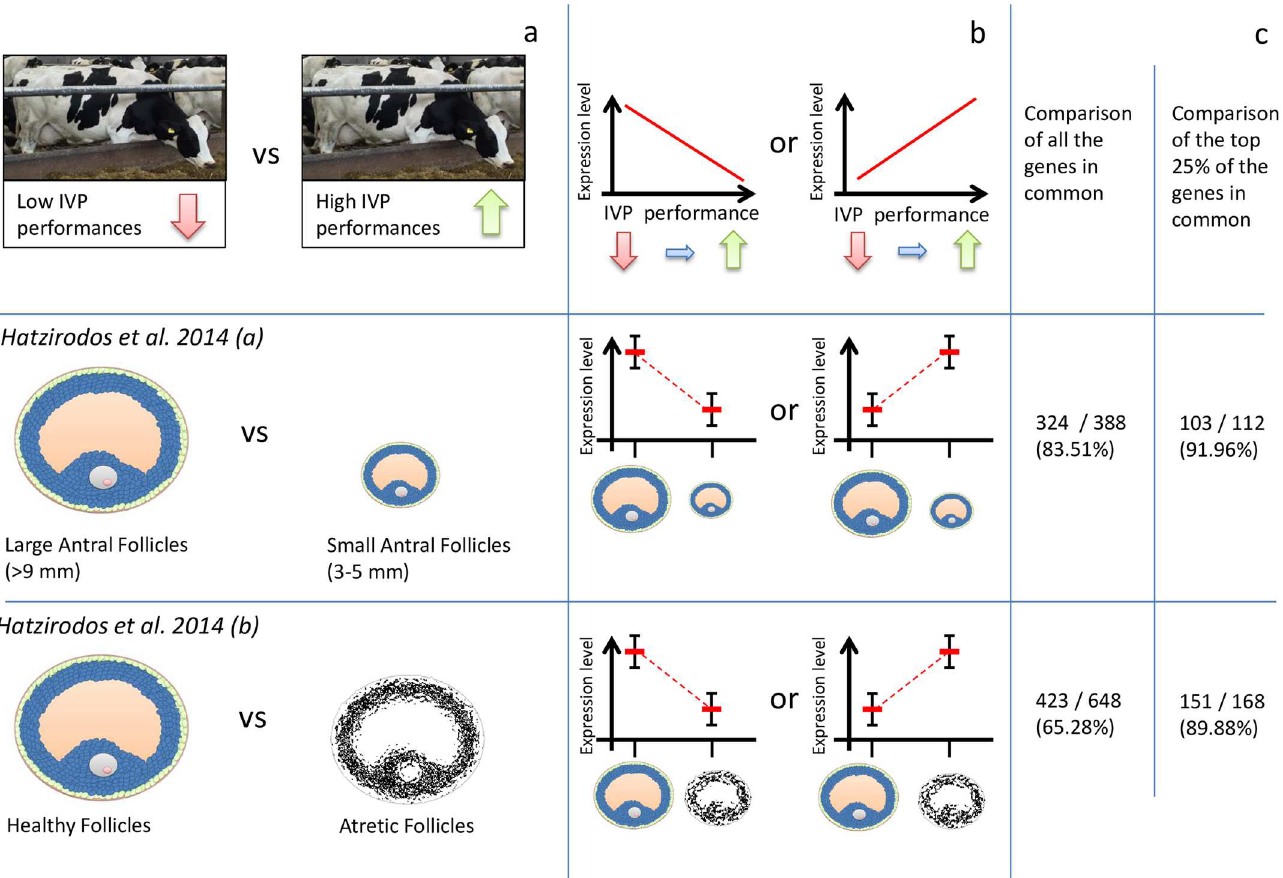
Fig 2. Comparison of expressionpattern with previous studies by (Hatzirodos et al .(a, b)) [30, 31]. ( a ) Description of our analysiswith respect to the differentialexpressionanalysesin (Hatzirodos et al .(a, b)) [30, 31]. The comparisonfrom (Hatzirodos et al .(a)) [30] is invertedin this picture in order to show the similarity of the patterns that we observed. ( b ) Explanationof the comparisons. A gene is considered to have the same trend when its expressiondecreasesor increasesin both the studies for each comparison. ( c ) Number of genesobservedwith similar trend duringthe comparisons. The numbersrefer to the genes with a similar trend with respect to the order describedin Fig 2a and 2b.